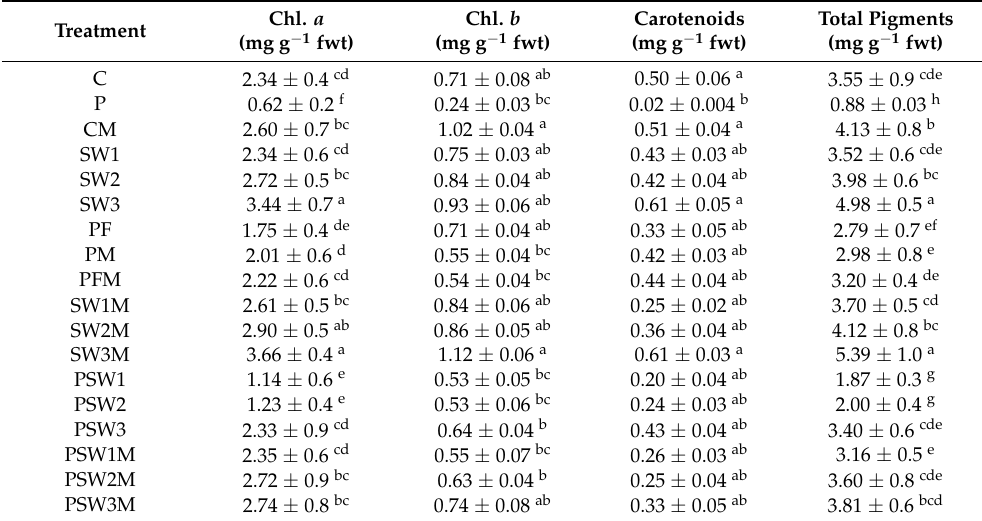
Table 6. Effects of application of the seaweed extract and/or colonization with arbuscular mycorrhizal fungi on total photosynthetic pigments in leaves of pea infected with Rhizoctonia root rot at 20 dpi *. Treatment